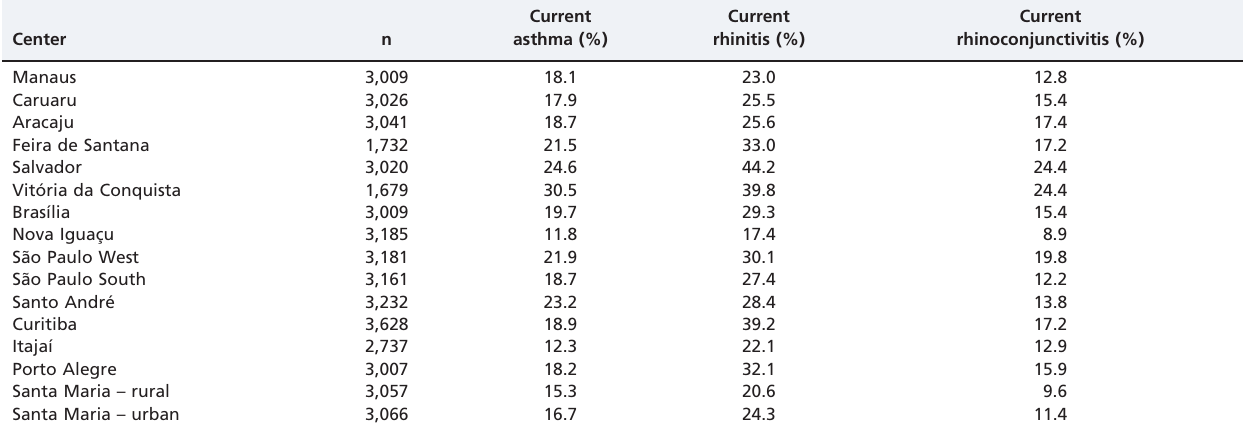
Table 1 - Prevalence of current asthma, current rhinitis, and current rhinoconjunctivitis in Brazilian adolescents from ISAAC Phase Three centers, based on responses to the ISAAC written questionnaire (determined with Spearman’s correlation